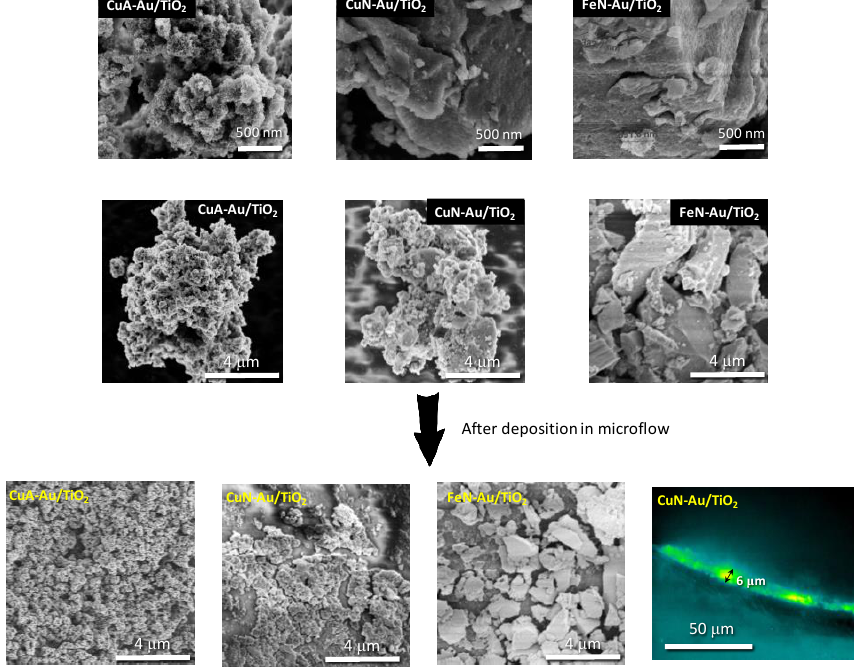
Figure 7. SEM and optical microscope image of sol – gel-synthesized bimetallic TiO 2 and after depo- Figure 6. SEM and optical microscope image of sol–gel-synthesized bimetallic TiO 2 and after deposi- sition in the PFA microreactor. tion in the PFA